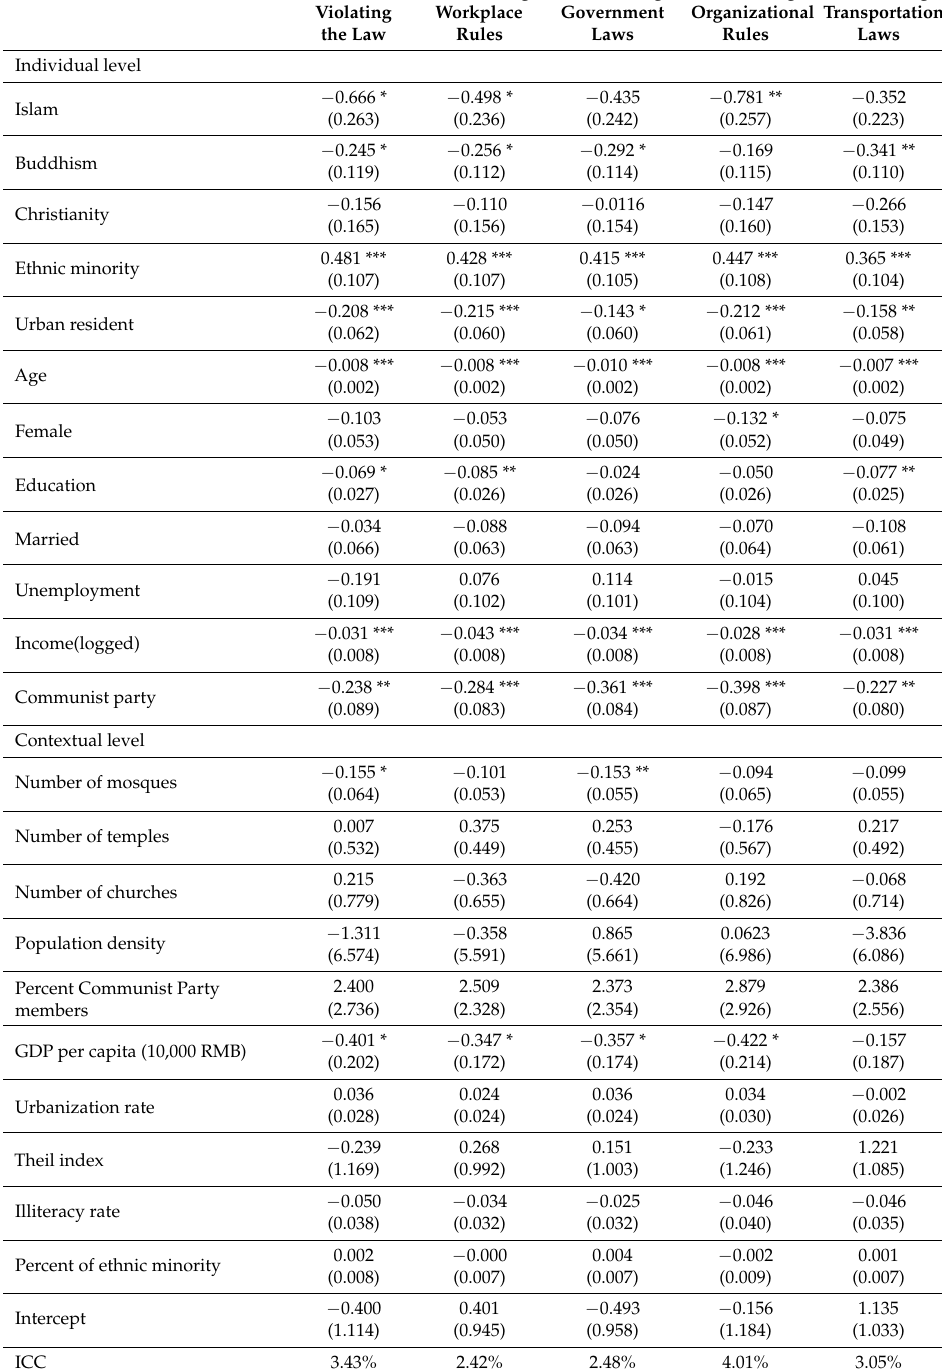
Table 2. Religion as an individual and contextual control (individual N = 8224; province N =